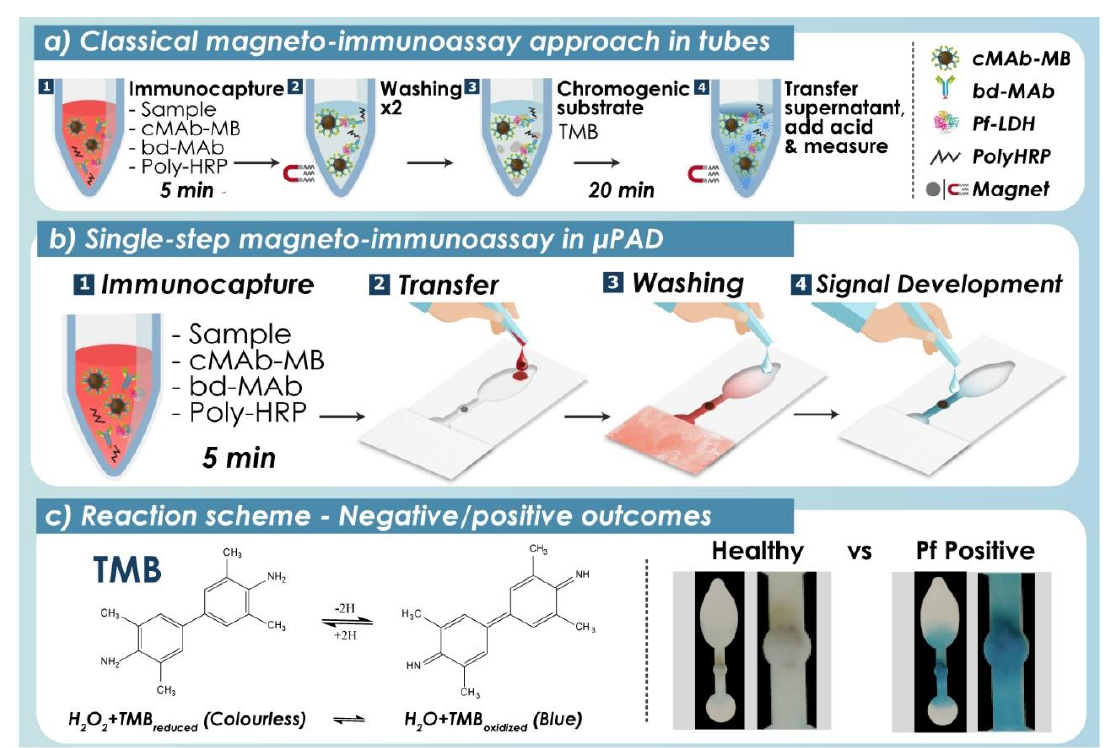
Figure 2. Single-step magneto-immunoassay carried out manually as reported in [28] ( a ) and using the µPAD developed here, which differed in size and shape from that in our previous work to better fit the requirements of colorimetric detection ( b ). ( c ) Scheme of TMB redox reaction (here, Poly-HRP catalyses TMB oxidation coupled to H 2 O 2 reduction for colour generation), and examples of negative and positive µPAD readouts.